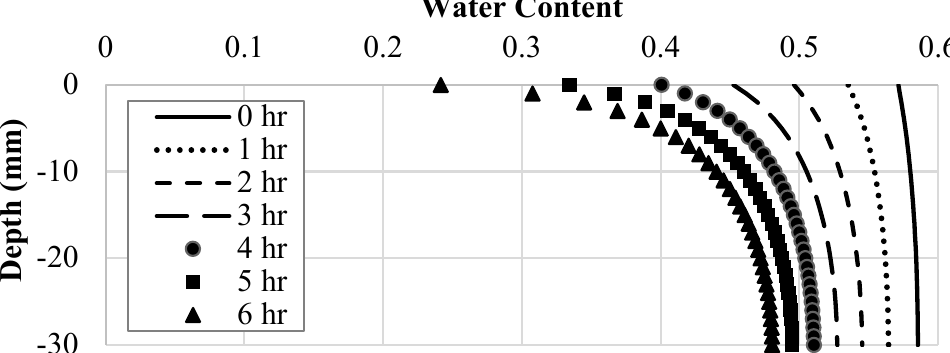
Figure 10. Suction as a function of depth and time in the hydro-mechanical model. Creating a water content field across the depth of the clay layer for each time step was the most valuable result calculated by the hydraulic model due to water content being an input in the model coupling process. As such, the gravimetric water content along the depth of the soil layer was plotted, with the time step representing each 60-min increment shown. As can be seen in Figure 11, the magnitude of the water content existing in the clay specimen decreases with each time step and increases as the depth increases. The water content at the soil’s surface changed by − 0.33 over six hours, while the change in water content at the bottom of the layer was only − 0.1. The observed trend was expected as the water could only evaporate the clay specimen through the top soil surface, making the water content at that point the lowest at all times. This also reflects the suction behavior because unsaturated soil mechanics dictate that a decrease in water content increases the soil suction.